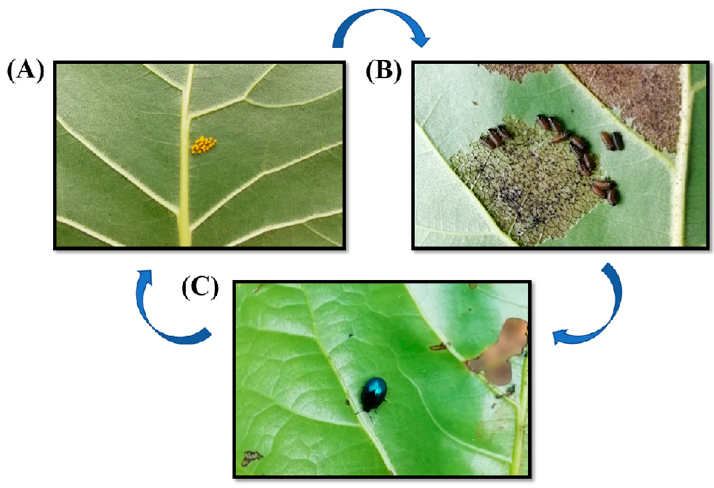
Figure 2. Diagram of P. versicolora ; ( A ) eggs, ( B ) larvae, ( C ) adult.